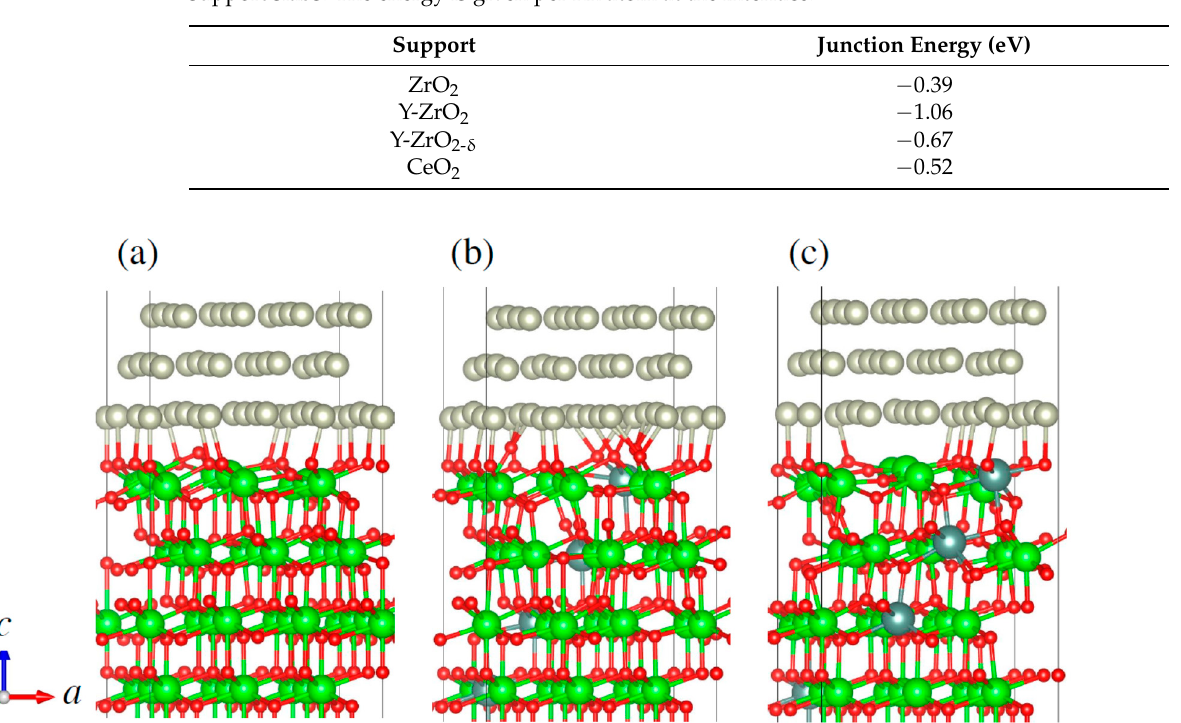
Table 2. Junction energies of the system with three-layered Rh(111) 4 × 4 structures joined to various support slabs. The energy is given per Rh atom at the interface.